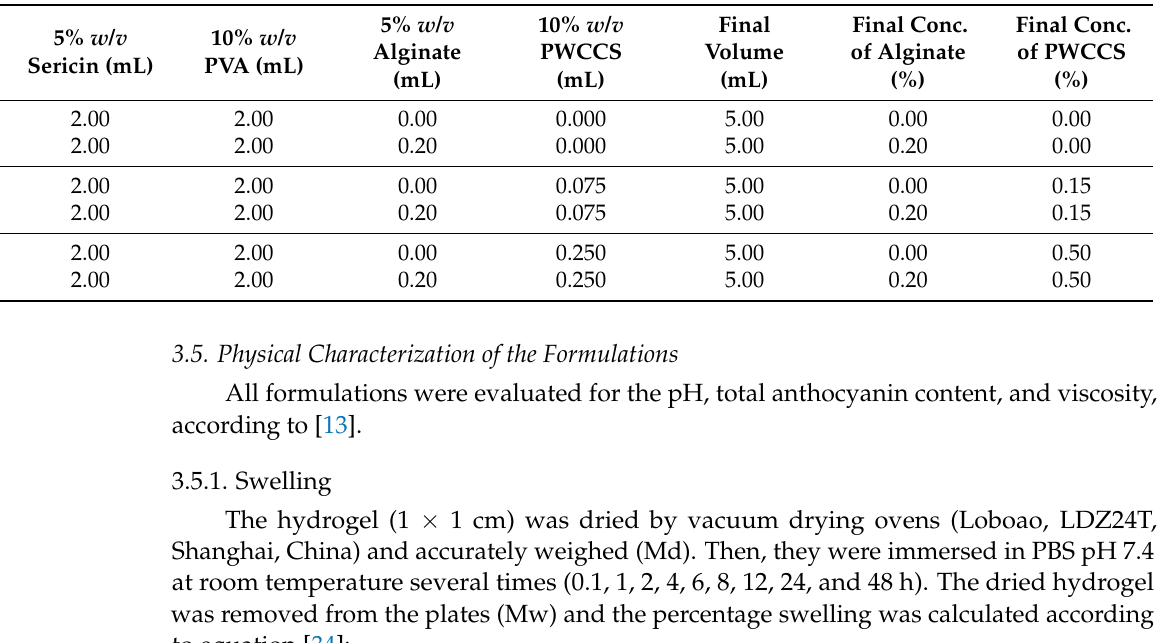
Table 3. The composition of the sericin hydrogel